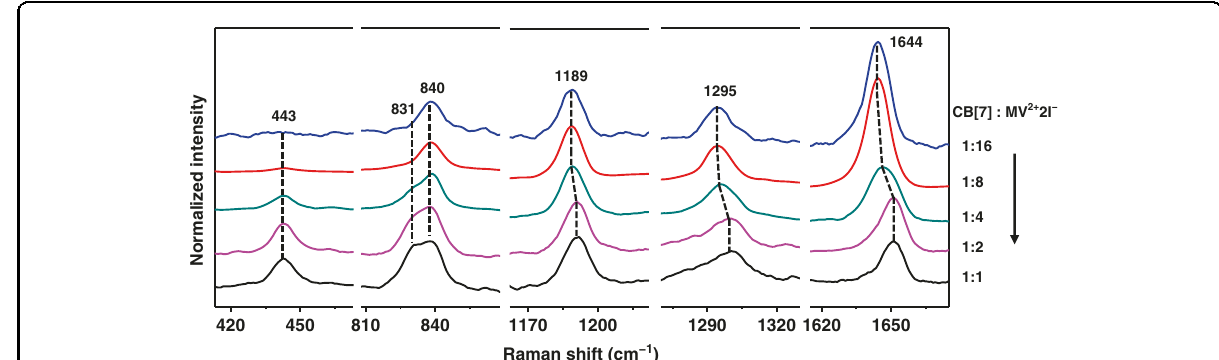
Fig. 4 Normalized SERS spectra (1189 cm − 1 peak of MV 2 + as standard) in ascending order of molar ratio of CB[7]:MV 2 + 2I − from top to bottom. The concentration of MV 2 + 2I − was kept constant at 2.5 μ M, and that of CB[7] varied at 0.16 μ M, 0.31 μ M, 0.62 μ M, 1.25 μ M, and 2.5 μ M from top to bottom